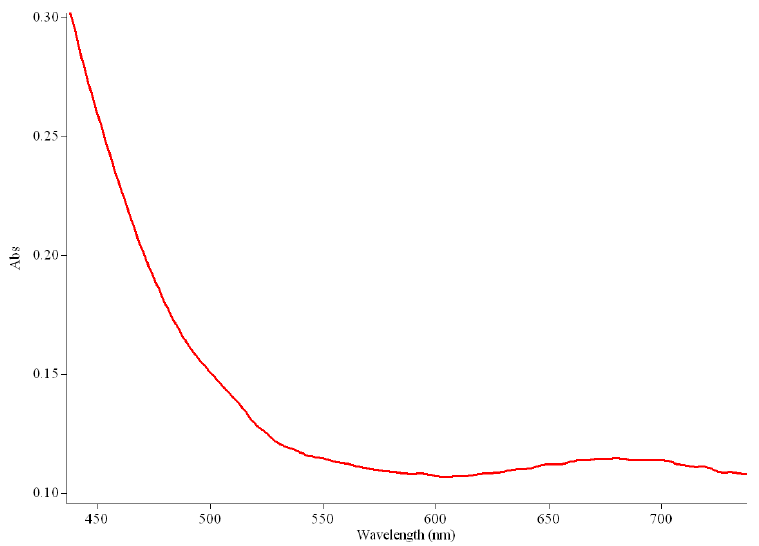
Figure 13. UV-vis spectrum for 4.